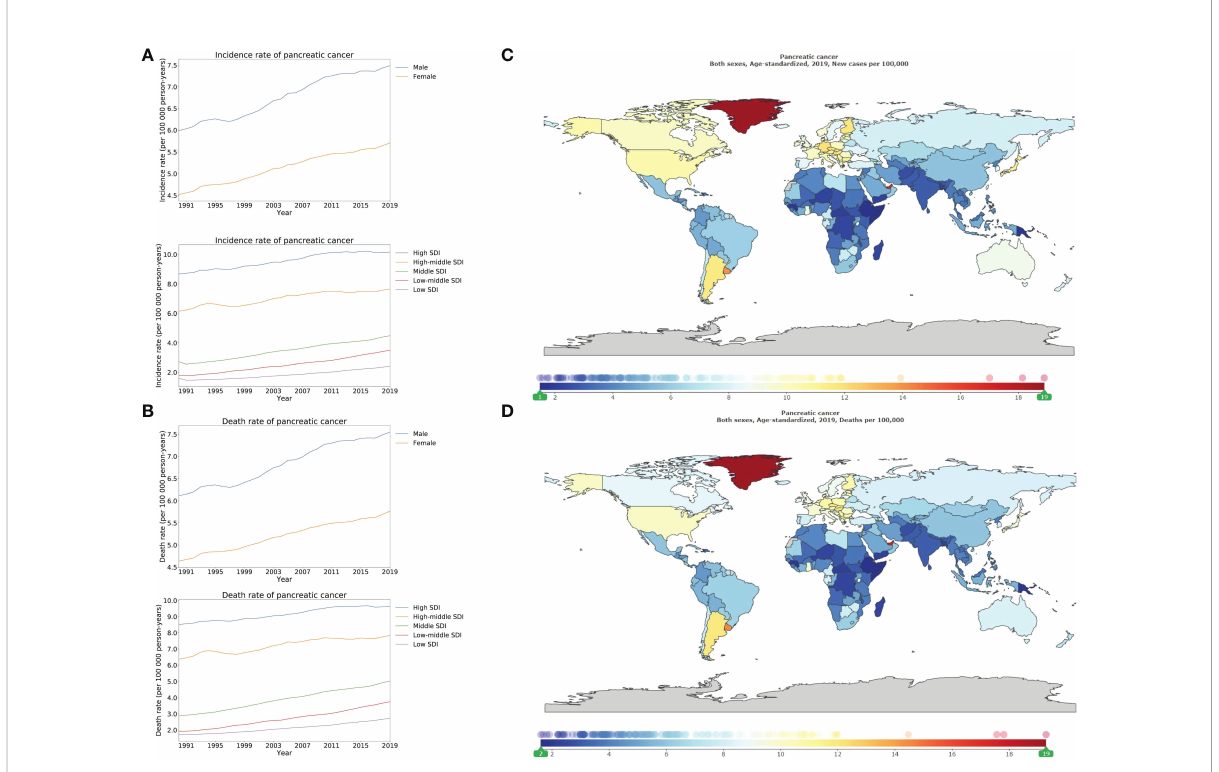
FIGURE 5 Burden of pancreatic cancer for 204 countries and territories. Age-standardized incidence (A) and death (B) rate per 100000 population of pancreatic cancer from 1990 through 2019 by country and territory, strati fi ed by sex or SDI; age-standardized incidence (C) and death (D) rate of pancreatic cancer per 100000 person-years by country and territory, in 2019. The maps in (C) and (D) were generated by GBD 2019